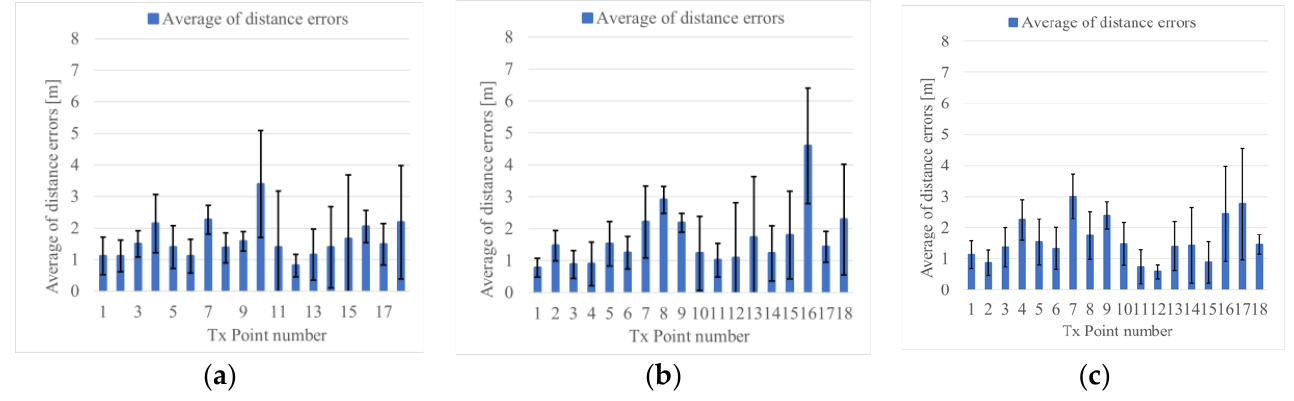
Figure 14. Position estimation results of measurement simulation in the T-shape road. ( a ) Rx moves to the left side of the road, ( b ) Rx moves to the middle of the road, ( c ) Rx moves to the right side of the road by the wall.